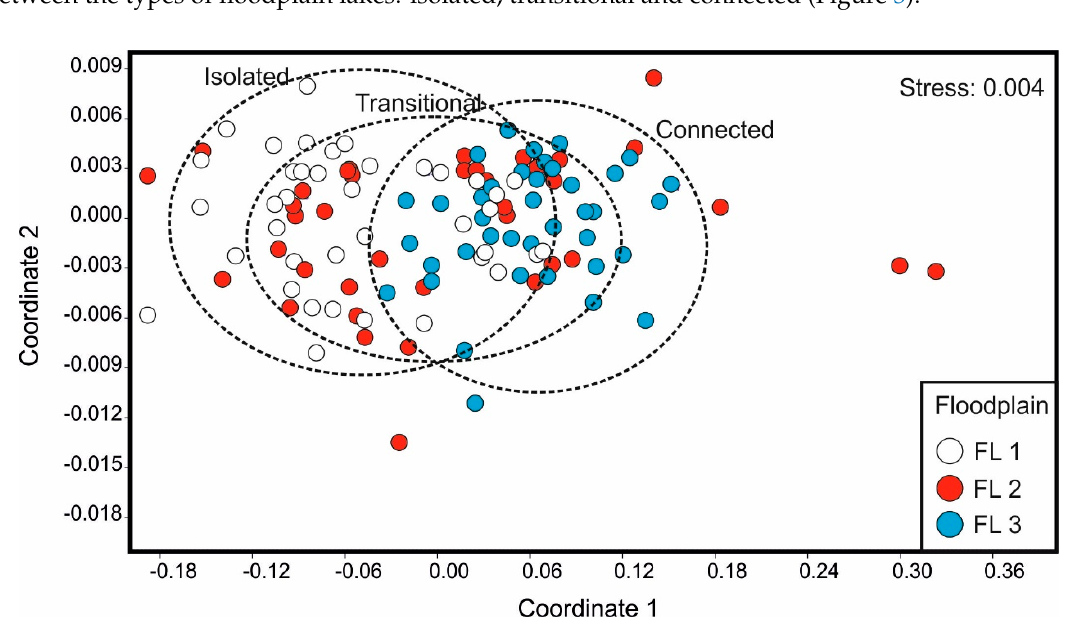
Figure 2. Hydrograph of the lower Vistula River from the gauge station in Toru ń . HW max —the maximum water level, LW min —the lowest water level. HW—average of high water levels, MW—average of mean water levels, LW—average of low water levels have been calculated from the study period 2006–2009 and 2013 (grey area indicates a period without sampling). Arrows with “s” indicate sampling times.